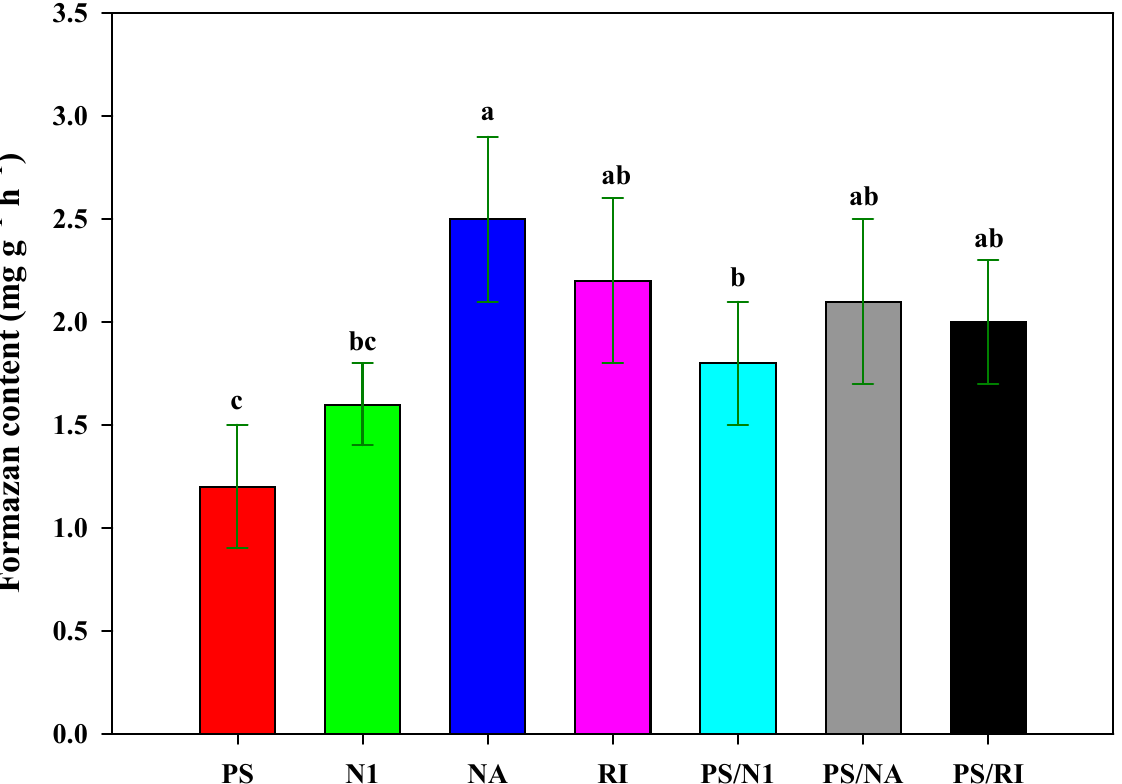
Figure 6. Root activity of one scion, three rootstocks, and three grafted cut rose flowers grown in the greenhouse during the summer season. PS: scion plant of spray rose Rosa hybrida cv. Pink Shine; N1: rootstock of Rosa multiflora cv. Hort No. 1; NA: rootstock of Rosa canina cv. Natal Briar; RI: rootstock of Rosa indica cv. Major; PS/N1: PS grafted onto N1; PS/NA: PS grafted onto NA; PS/RI: PS grafted onto RI. Vertical bars are standard deviations ( n = 3). Small letters at the data points indicate mean separation between the values by Duncan’s multiple range test at p = 0.05.